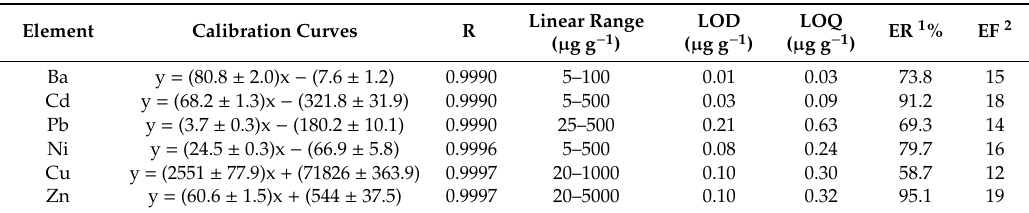
Table 2. Validation results for the proposed method.